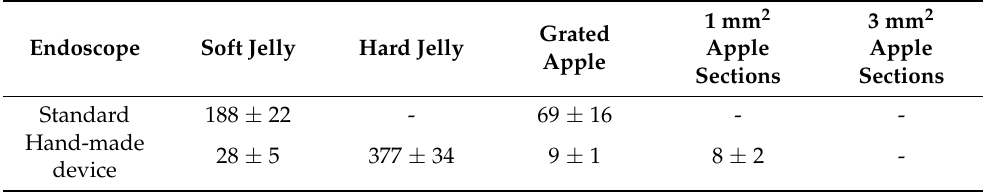
Table 2. Procedure time in the ex vivo study.